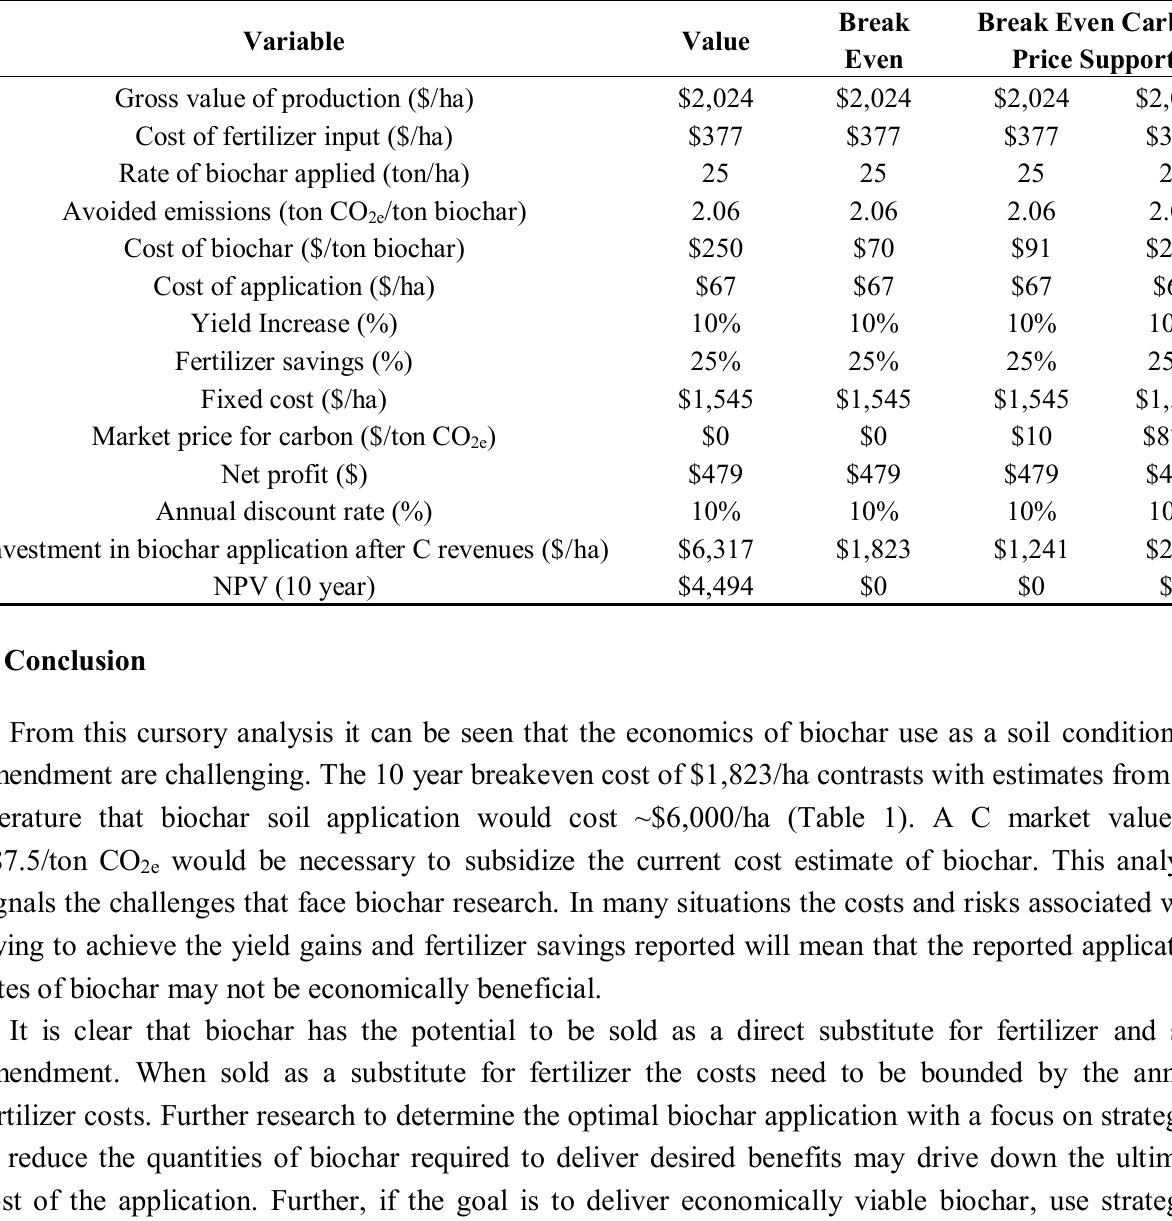
Table 2. Breakeven analysis of biochar soil